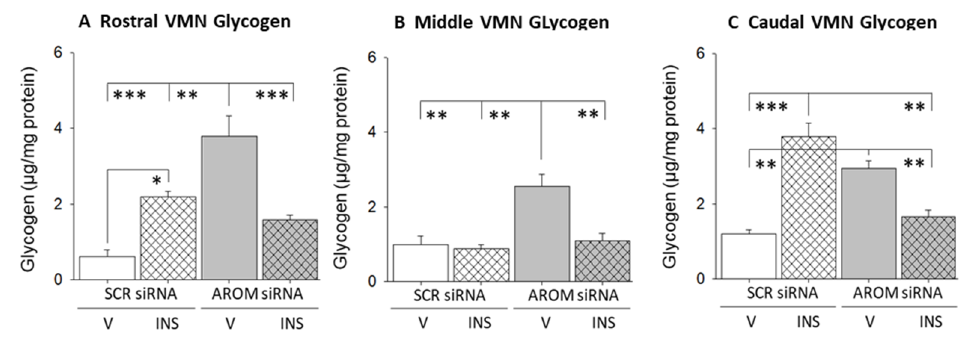
Figure 4. Effects of VMN aromatase gene knockdown on tissue glycogen concentrations in eu- and